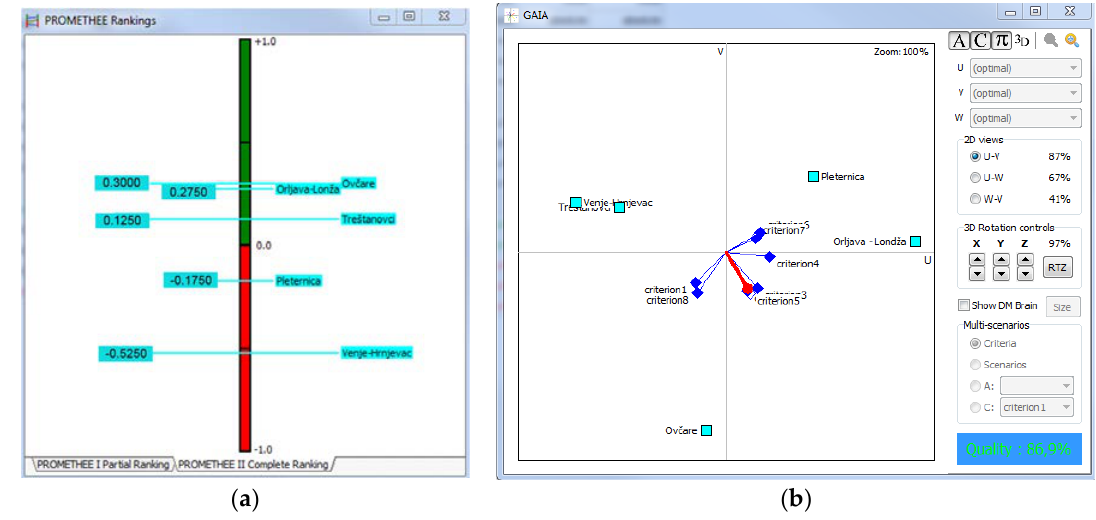
Figure 3. Results of PROMETHEE II application for Scenario 1: ( a ) complete ranking scheme of proposed alternatives, and ( b ) GAIA (Geometrical Analysis for Interactive Decision Aid) plane.